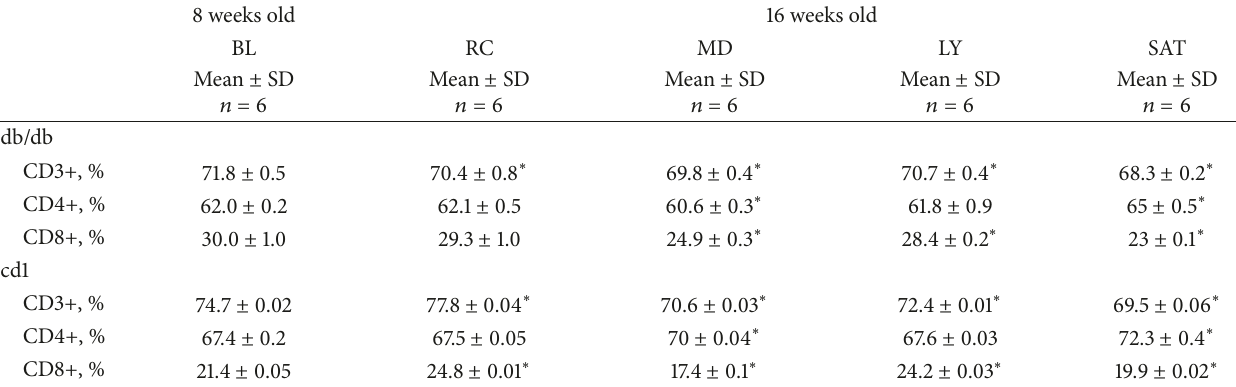
Table 3: Effect of supplementation with EPA and DHA extracted from microalgae in lymphocytes populations in db/db and CD1 mice.